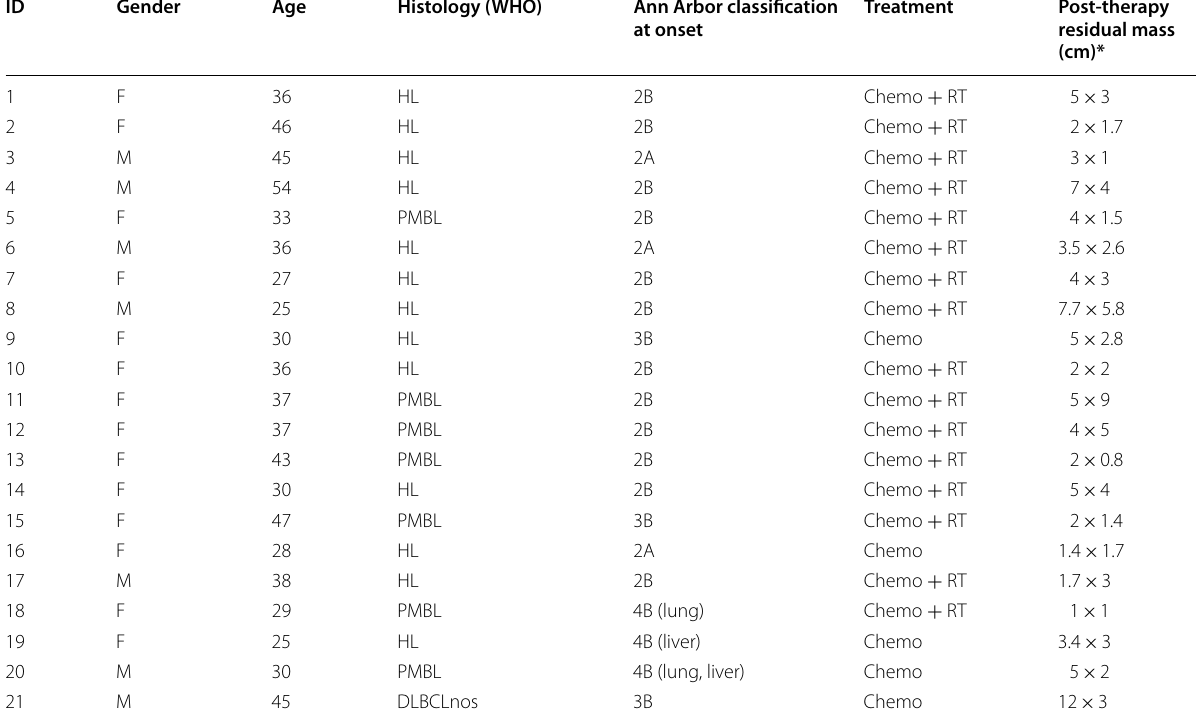
Table 1 Patients’ clinical and demographic characteristics